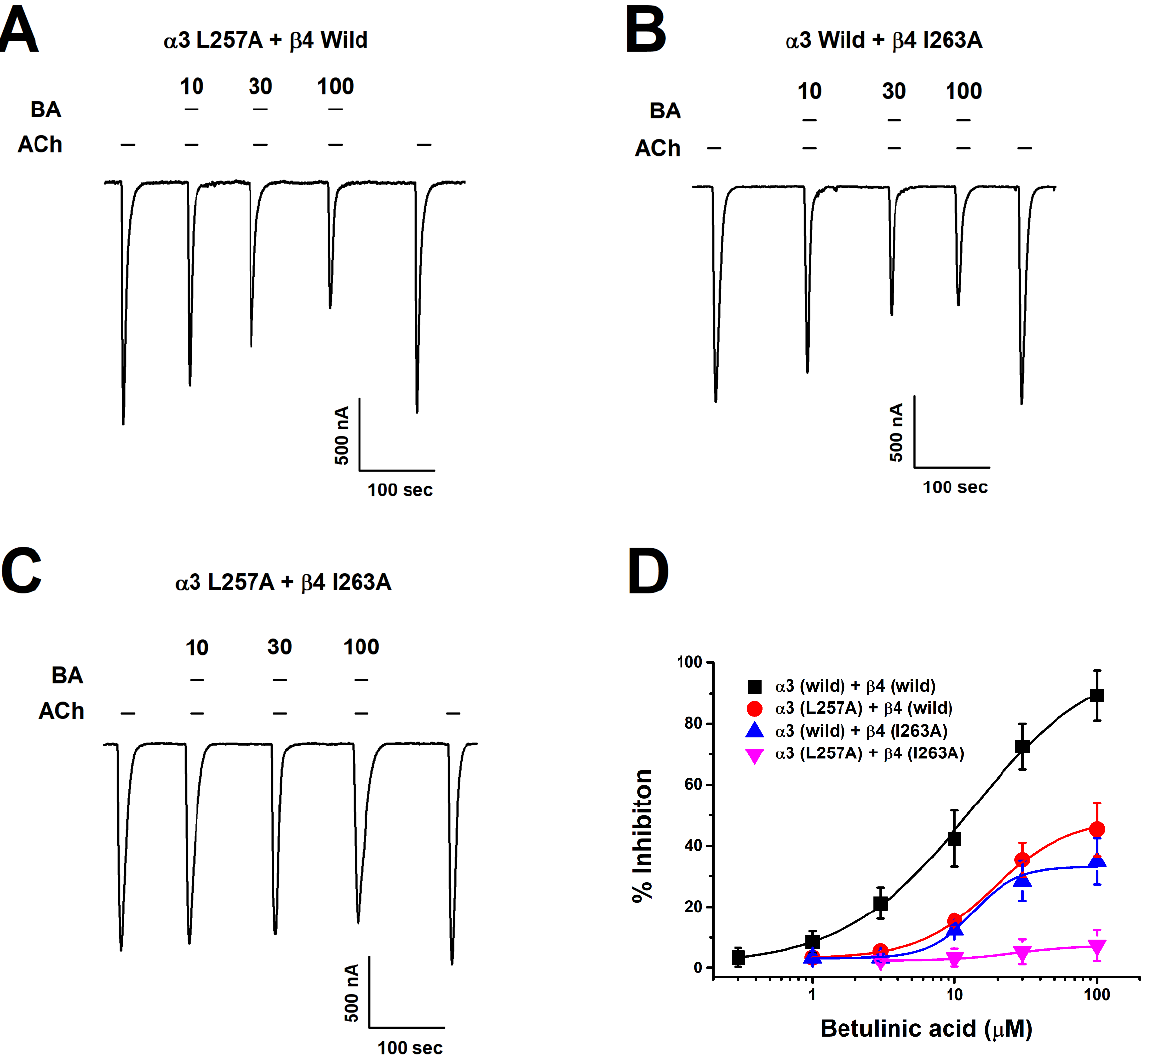
Figure 5. Inhibition of BA by α 3 β 4 nAChRs mutant types. ( A – C ) Concentration-response of inward current depending on mutant type. ACh and BA were co-applied. The applied ACh concentration was fixed at 100 µ M while BA concentrations included 10, 30, and 100 µ M ( n = 7–10 from four different frogs). ( D ) Graph represents the inhibition of BA activity by mutant type at various concentrations. Each point is presented as mean ± SEM ( n = 7–9/group). Detailed values are shown in Table 1. Table 1. Effects of BA on subunit mutants of α 3 β 4 nicotinic acetylcholine receptor. Subunit